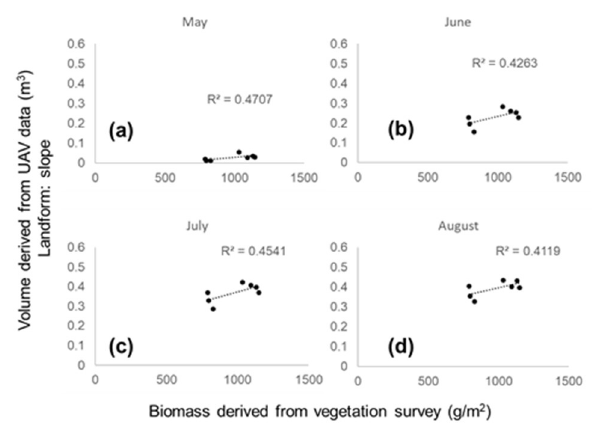
Figure 10. Comparison between volume of M. sinensis derived from UAV data: May (a), June (b), July (c) and August (d), and